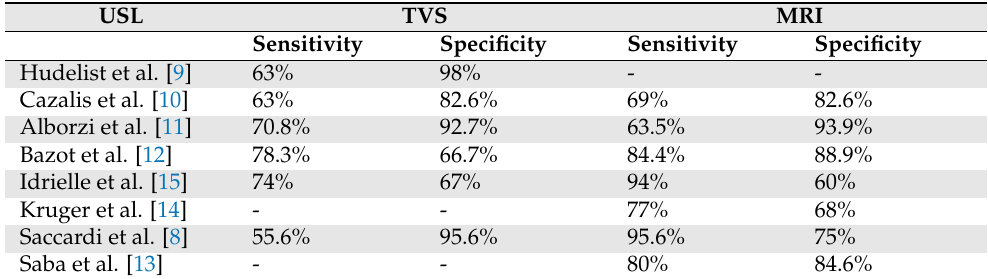
Table 3. The diagnostic accuracy of TVS and MRI in uterosacral ligaments DE (as reported in different studies). USL TVS